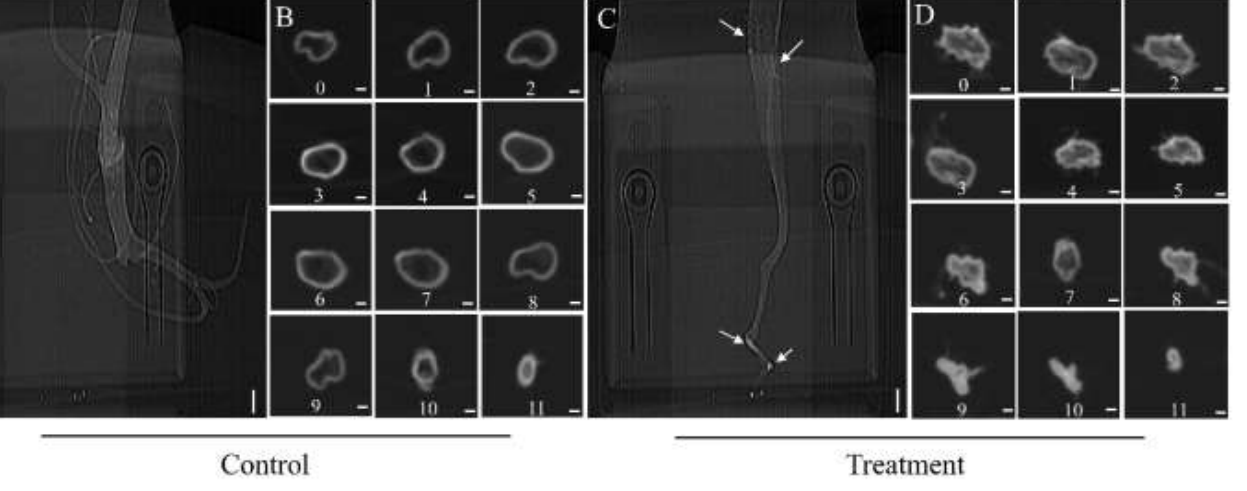
Figure 3. X-ray CT imaging of the root of poplar. ( A ) A preview of the root system; ( B ) different cross-sectional views of the root; ( C ) preview of the root system; ( D ) different cross-sections of the root system. The number represents the cross section (cm) of the root system from top to bottom. The scales ( A , C ) are 0.5 cm, while scales ( B , D ) are 0.2 mm. The white arrow represents the location of the density changes.